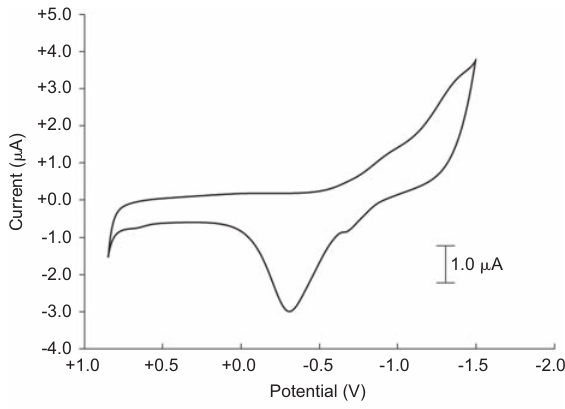
Figure 3 Cyclic voltammogram of [Cd II (L)( µ -Cl)Cd II Cl 0.1 M TEAP-DMSO solution at 20.0 ± 0.1 ° C.